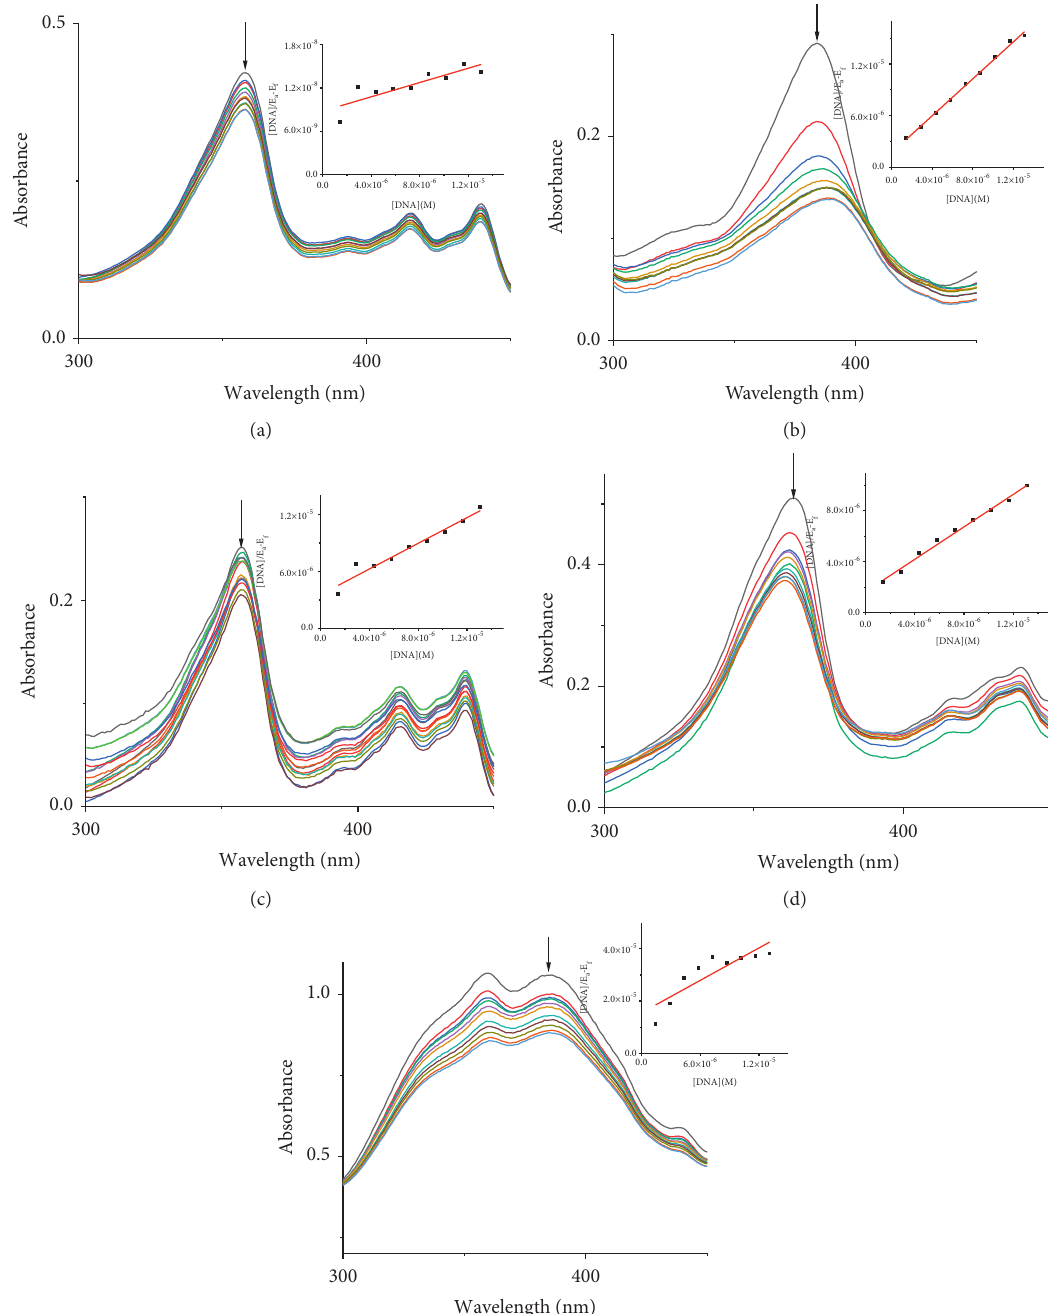
Figure 5: Absorption spectra of (a) Co-PLY 1 , (b) Mn-PLY 2 , (c) Ni-PLY 3, (d) Al-PLY 4 , and (e) Fe-PLY 5 complexes with the increasing amounts of SS-DNA (0–100 μ L). The arrow shows that the absorption changes as the amount of DNA increases. Inset: (DNA)/( E a − E f ) versus (DNA)